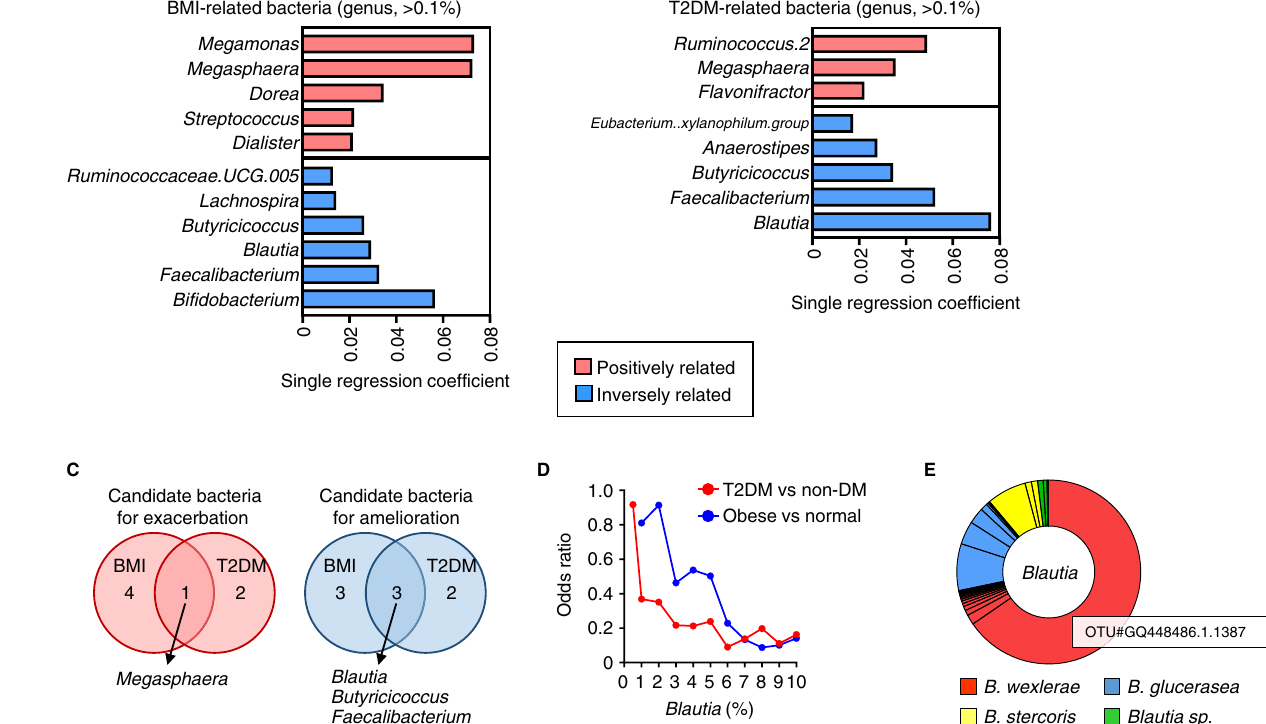
Fig. 1 | Intestinal bacterial genera associated with body mass index (BMI) and type 2 diabetes mellitus (T2DM) in Japanese adults. A BMI-related bacterial genera, which were selected and ranked according to R 2 score from single regres- sion analysis ( P <0.05) among 16 genera that were identi fi ed through multiple- regression analysis by forward selection (Supplementary Table 3) by using the data of the 217 participants (Supplementary Table 1). B T2DM-related bacterial genera, whichareselectedandrankedaccordingto R 2 scorefromsingleregressionanalysis ( P <0.05)among22generathatwereidenti fi edthroughmultiplelogisticregression